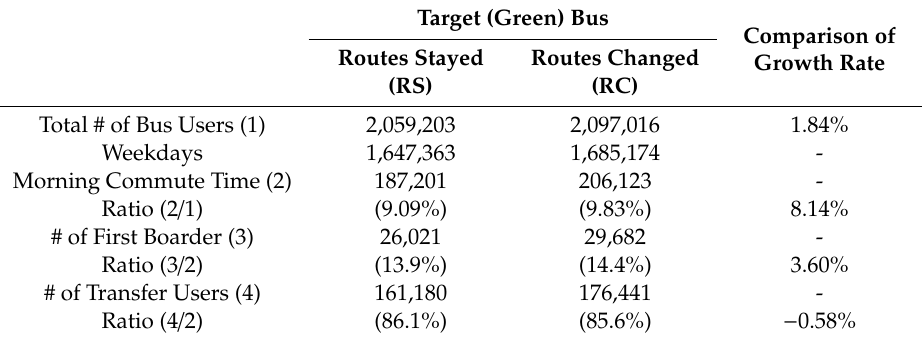
Table 6. Period after route change (six months, May–October, in 2018).